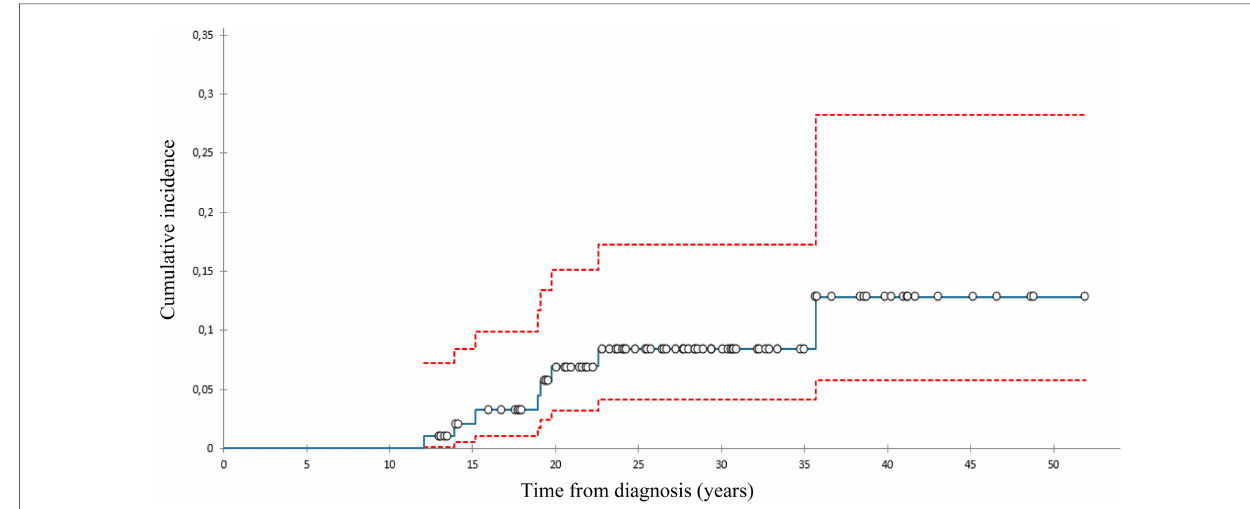
FIGURE 1 Cumulative incidence of subsequent breast cancer (with 95% con fi dence interval), all patients.